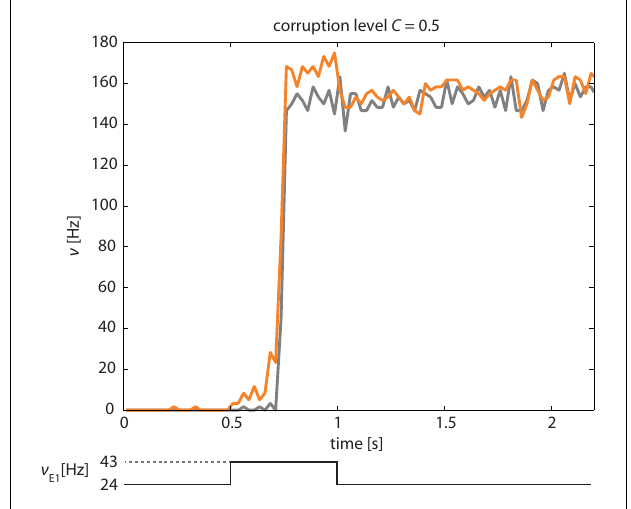
FIGURE 11 | Correction of “corrupted” input pattern. An external stimulus (increase of ν E1 from 24 to 43Hz) is applied selectively to half of E att and half of the E bkg neurons (corruption level C = 0.5).The network corrects this “corrupted” input and transitions into the “high” meta-stable state with both stimulated and non-stimulated E att neurons (orange and gray curves, respectively). Activity of E bkg neurons remains below 30Hz (not shown).